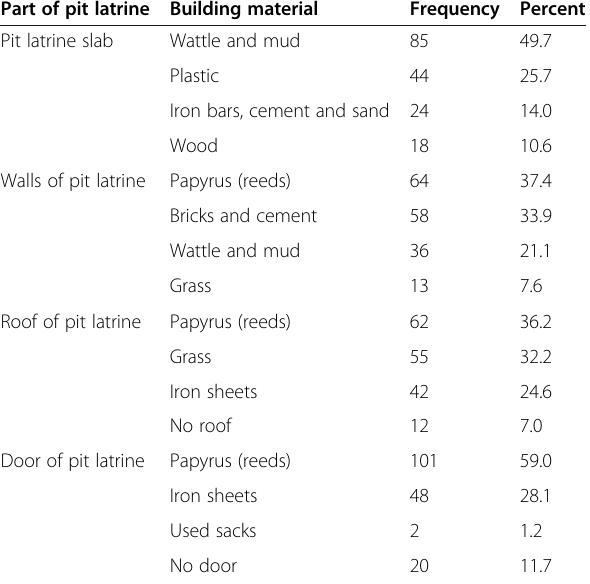
Table 3 Materials used to construct pit latrines in Bidibidi refugee